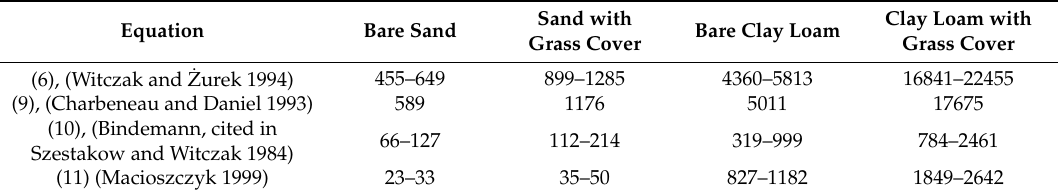
Table 5. Estimates of travel time (days) from analytical equations 1